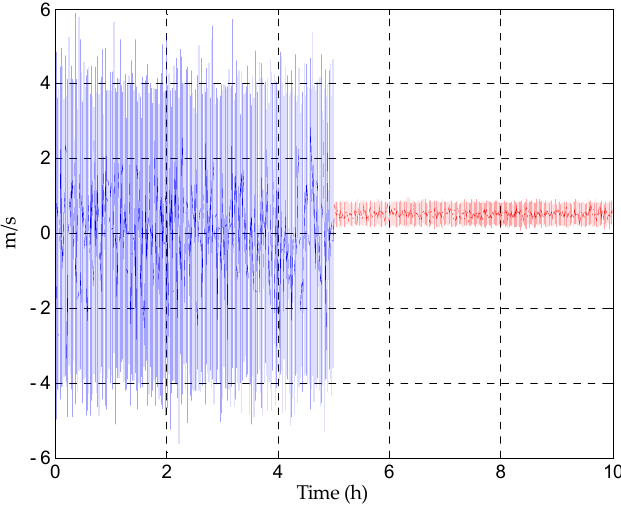
Figure 8. The error of the grid east reference